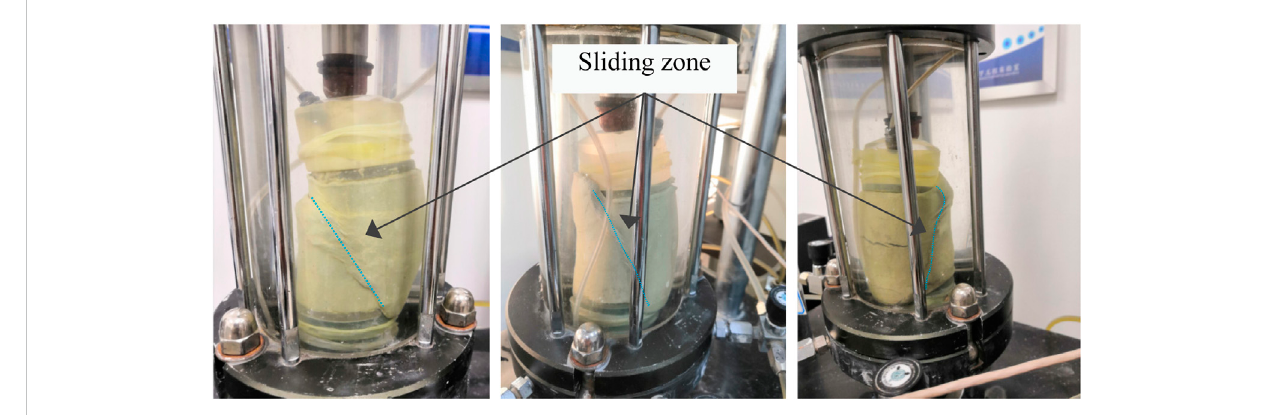
FIGURE 9 Strain softening accompanied by shear zone formation.